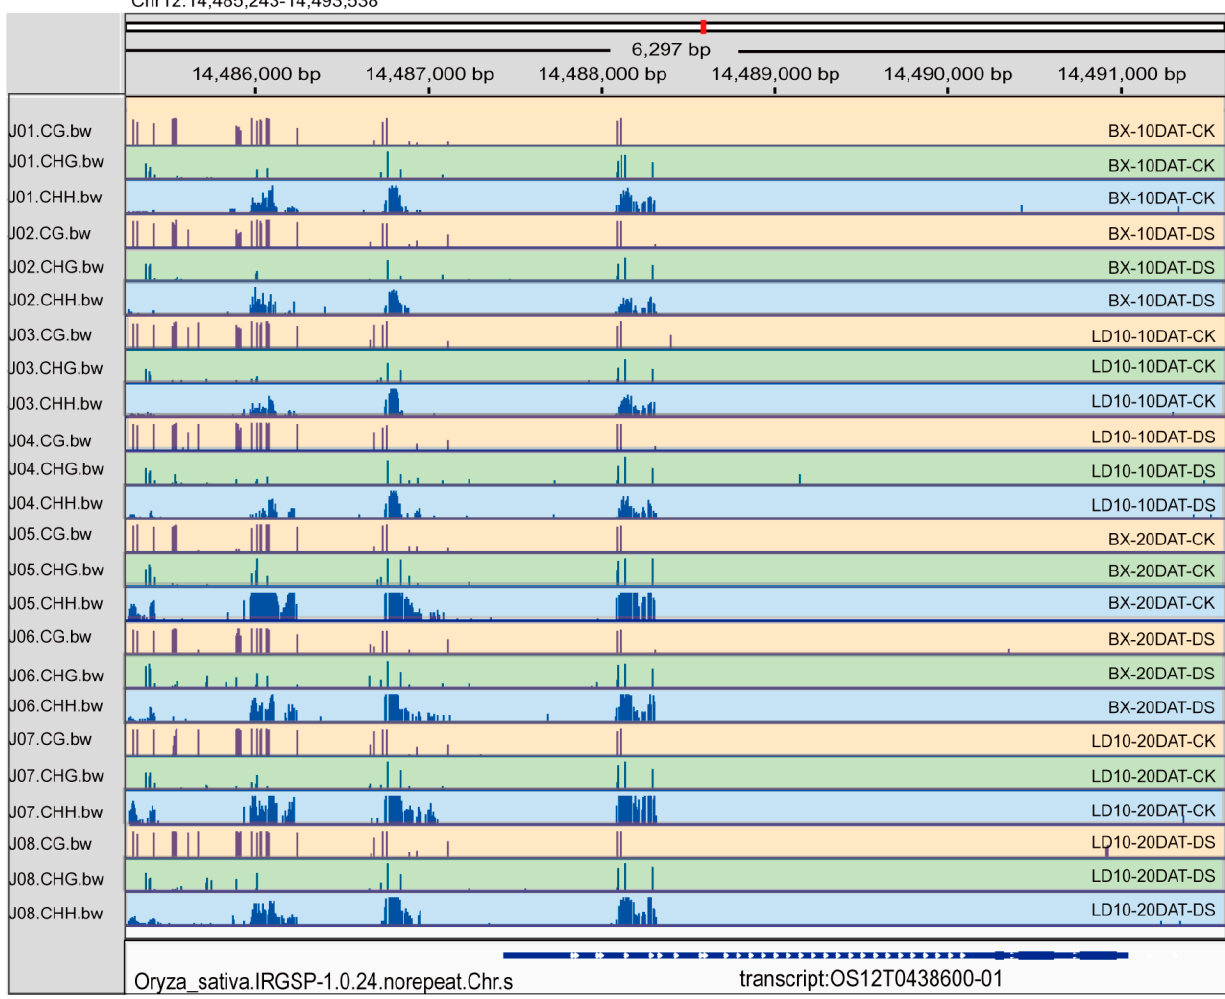
Figure 8. Distribution of the expression level of three methylation types (CG, CHG, and CHH) for the CLT1 (Os12g0438600) gene in two rice accessions with or without drought stress treatment.